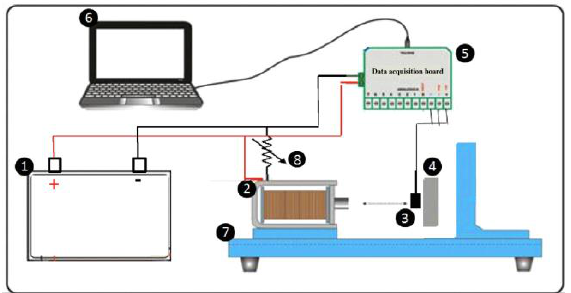
Figure 2. Experimental setup used: (1) Power supply, (2) solenoid, (3) hall sensor, (4) material sample, (5) data acquisition board, (6) computer, (7) test bench, and (8) potentiometer.